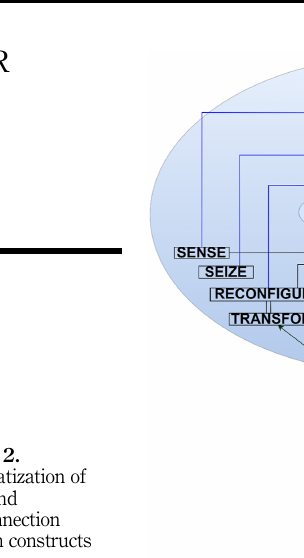
Figure 2. Systematization of codes and interconnection between